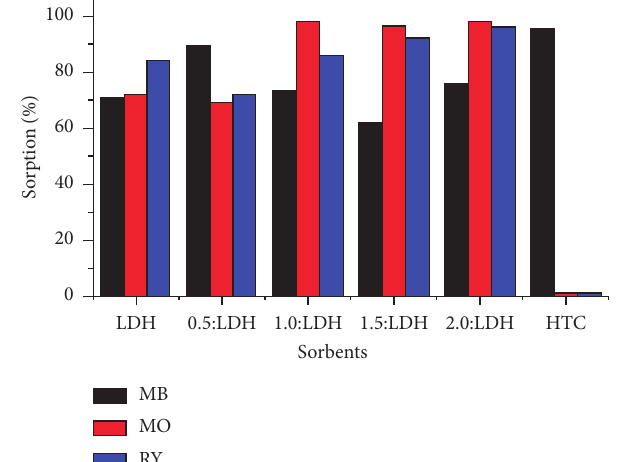
Figure 7: Adsorption of selected dyes onto various prepared materials (LDH, C-1 to C-4, and HC). Operating conditions: 20mL of dye solution (i.e., 50mg L − 1 ), 1.5g L − 1 of adsorbent, and 60min of stirring at 100rpm.